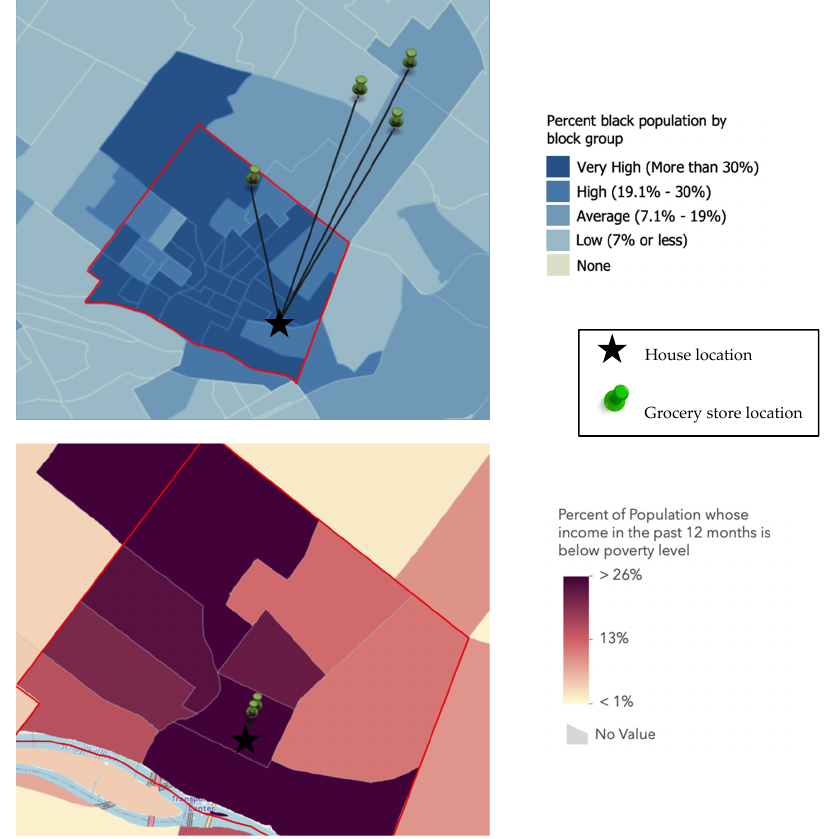
Figure 1. Maps for two participants, showing their home location and all the stores they reported shopping at in the previous four weeks.